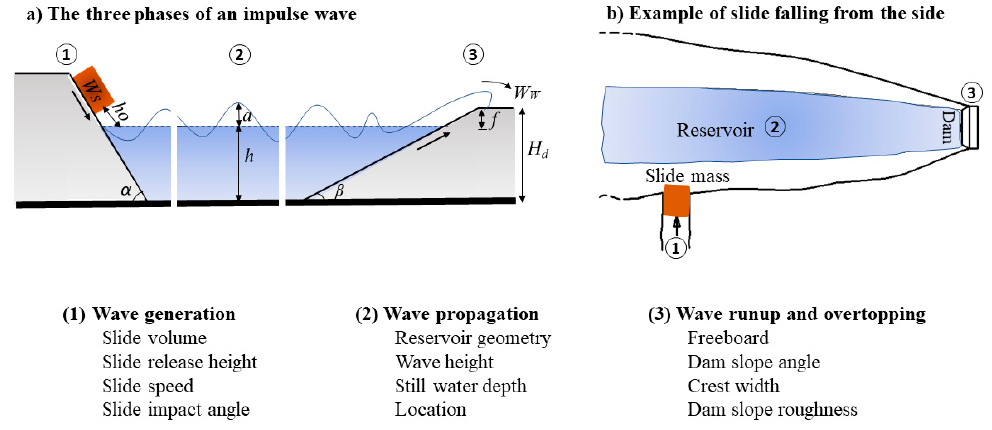
Figure 2. The three phases of landslide-generated waves with the relevant parameters for this study: (1) slide impact with wave generation; (2) wave propagation; and (3) wave run-up and overtopping of a dam; ( a ) a section showing the three phases based on Heller et al. [2]; ( b ) an example plan view of a reservoir.